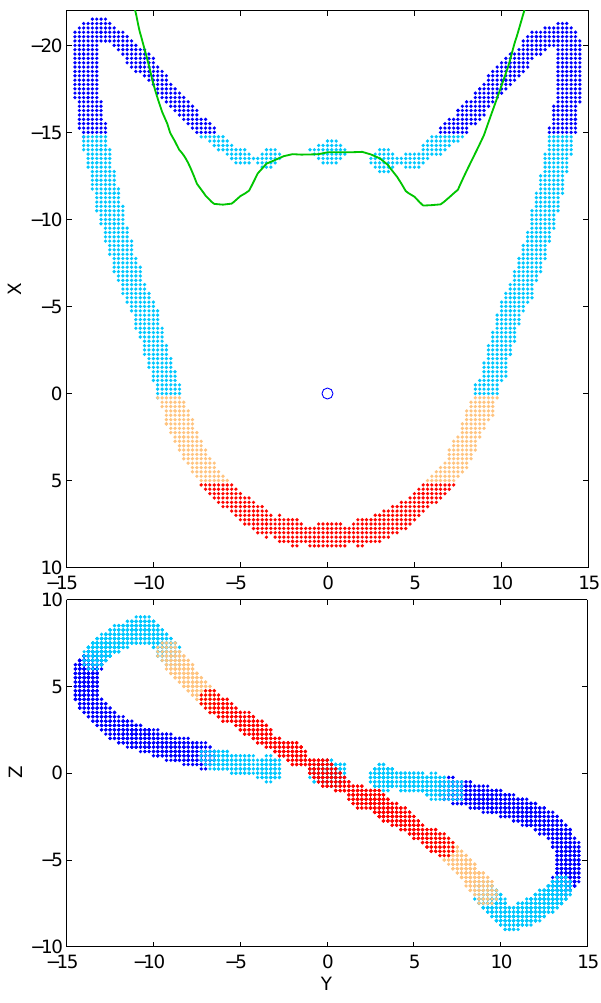
Fig. 3. The four-field junction in Gumics-4, seen from north (upper panel) and from the Sun (lower panel). The points are coloured by their X coordinate to aid in identifying different parts of the junction in the lower panel. The green line is the magnetotail x-line given by an independent search procedure based on the local field